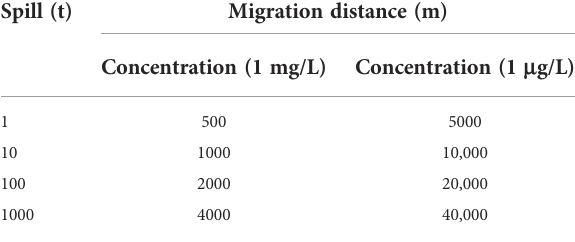
TABLE 4 The concentrations of ACN with different spills in water and its migration distance. (adopted from IMO/UNEP, 2009). Spill